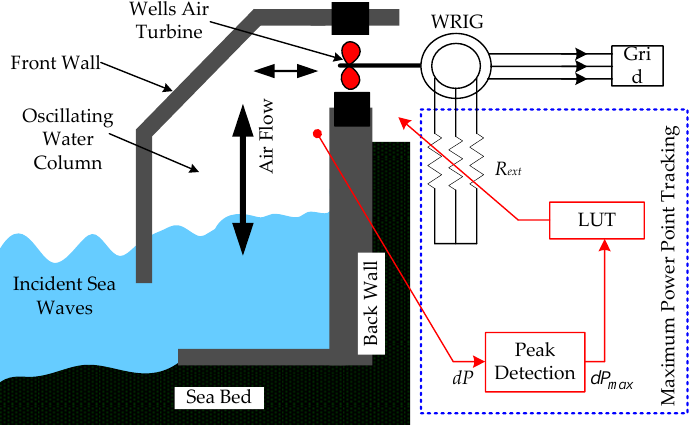
Figure 1. Schematic diagram of oscillating water column (OWC) plant.